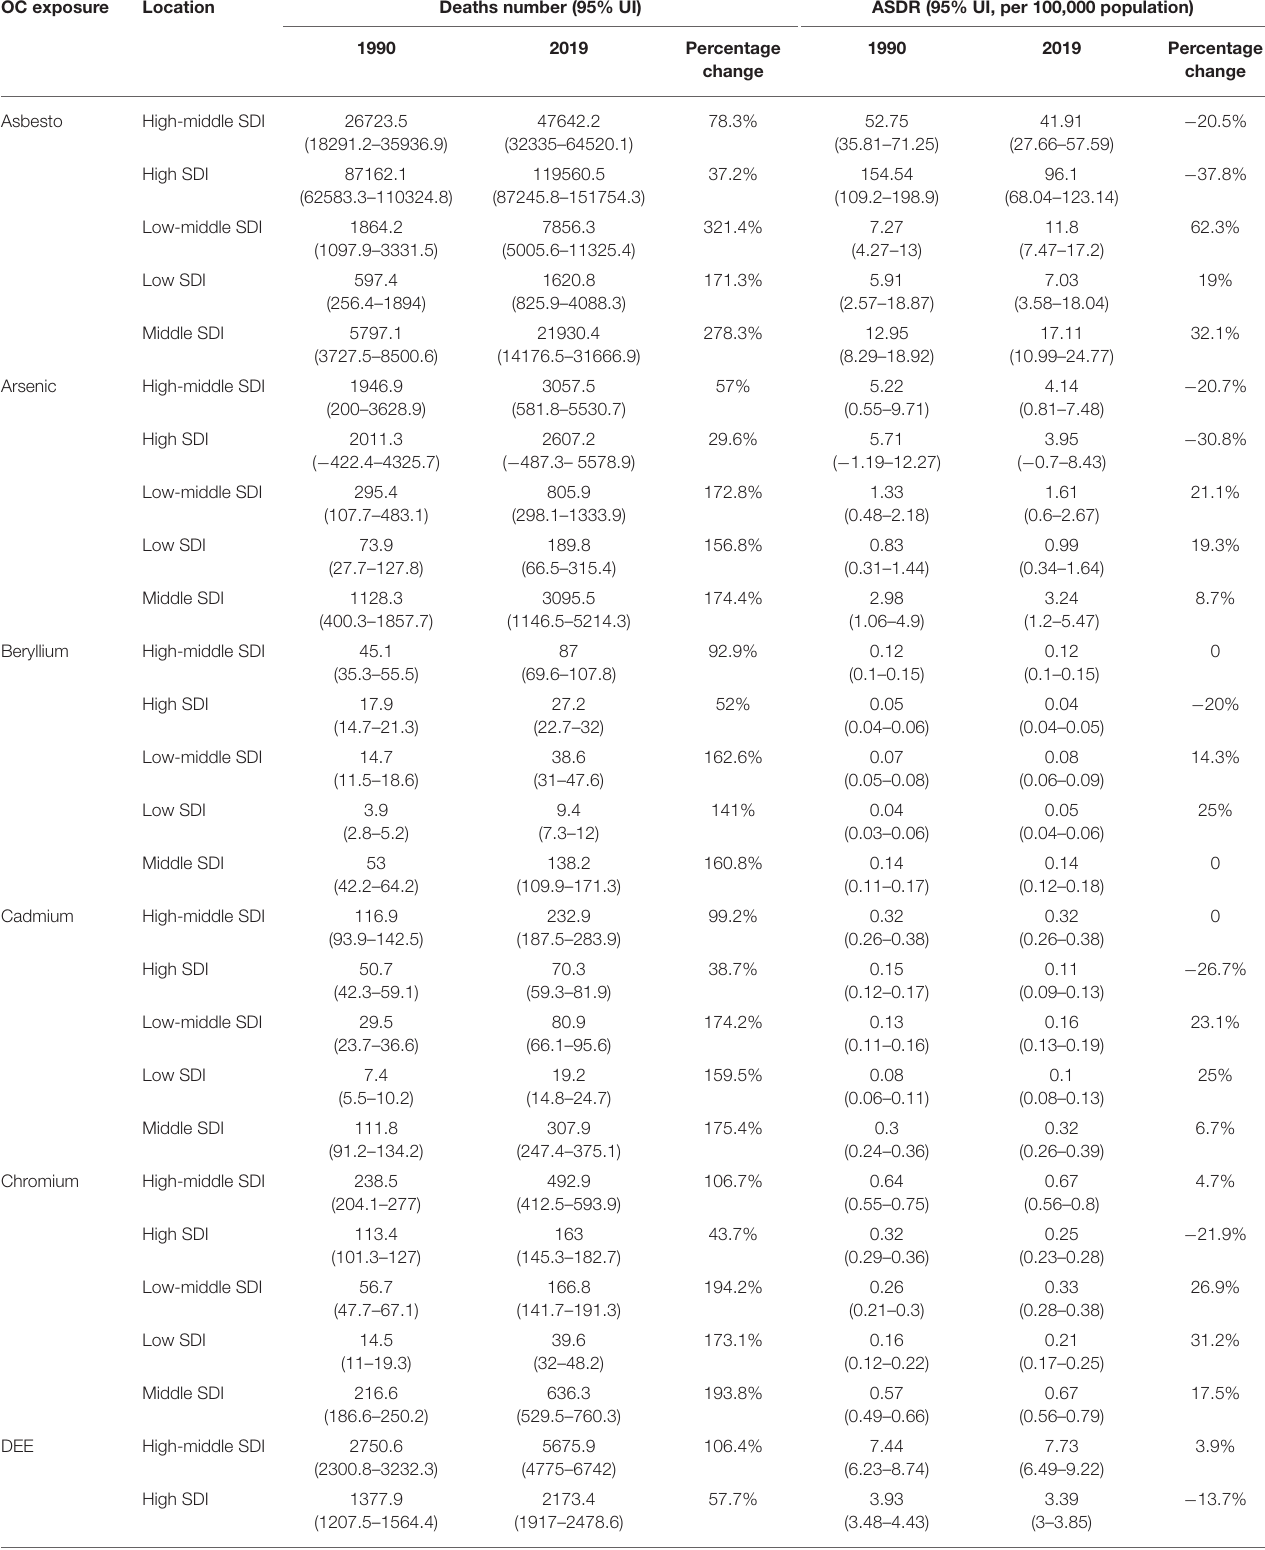
TABLE 2 | All age deaths and age-standardized DALY of patients with TBL cancer exposure to OCs across countries with different SDI values. OC